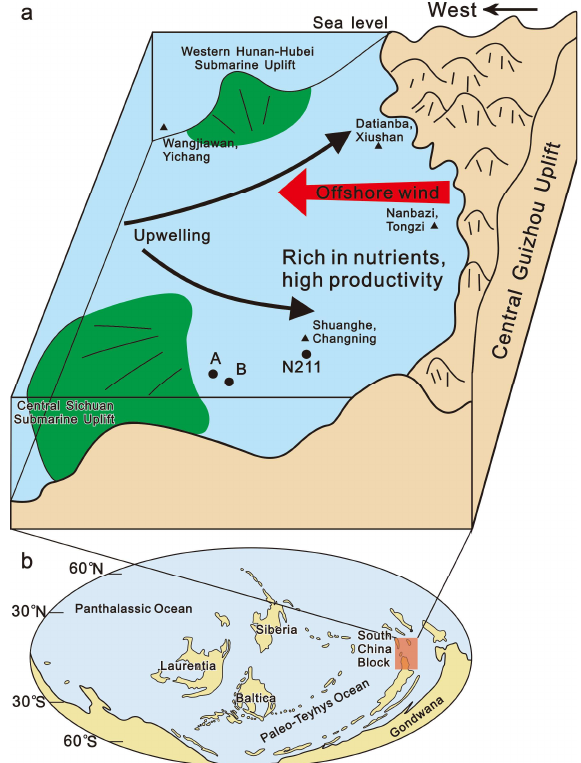
Figure 7. Upwelling formation model during the sedimentary period of the organic-rich shales in the Wufeng and Longmaxi Formations of the Upper Yangtze region. ( a ) Upwelling formation model; ( b ) Location of the South China Block (based on the results of Zhou et al.